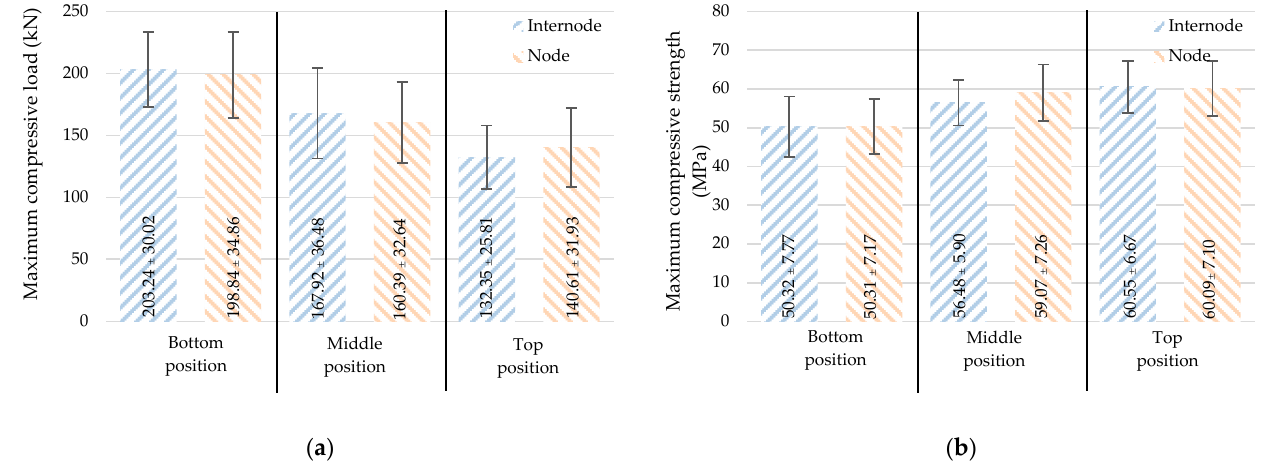
Figure 10. Compressive strength: ( a ) maximum compressive load and ( b ) maximum compressive strength (mean ± standard deviation). Figure 10a, b show the effect of position on the axial load capacity. The maximum compressive load decreases with height. The means with their corresponding deviation values at the bottom, middle, and top were 200.76 ± 32.49 kN, 164.95 ± 34.70 kN, and 135.95 ± 28.55 kN, respectively. According to Figure 10b, in contrast to the maximum compres- sive load, the maximum compressive strength increases with height. The figures were 60.35 ± 6.77 MPa, 57.50 ± 6.49 MPa, and 50.32 ± 7.34 MPa, respectively, for the average